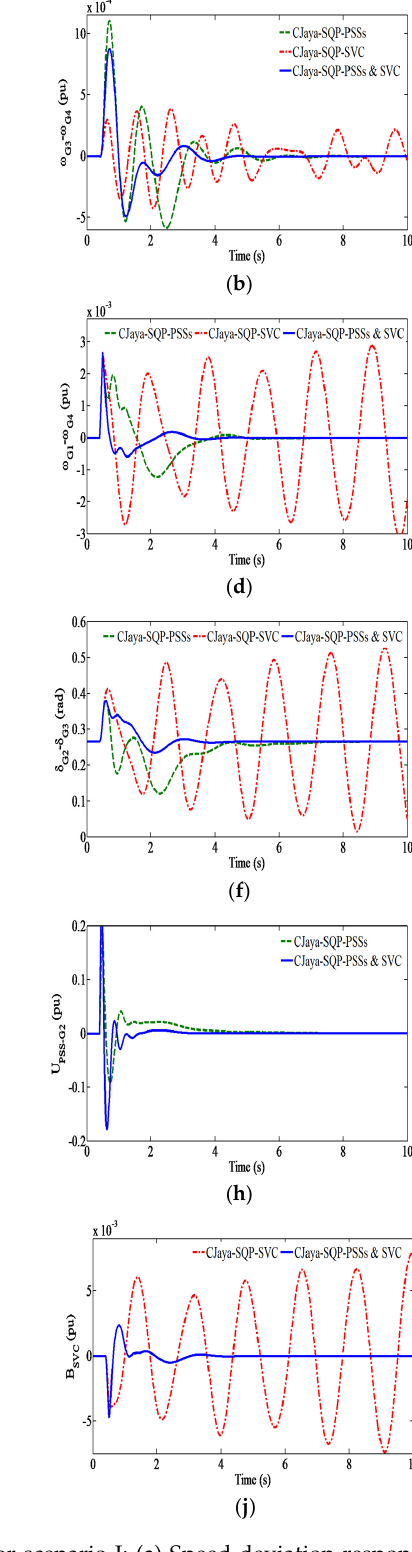
Figure 17. Power system dynamic responses for scenario I: ( a ) Speed deviation response of G1-G2; ( b ) Speed deviation response of G3-G4; ( c ) Speed deviation response of G1-G3; ( d ) Speed deviation response of G1-G4; ( e ) Rotor angle response of G1-G3; ( f ) Rotor angle response of G2-G3; ( g ) PSS output signal response at generator G1; ( h ) PSS output signal response at generator G2; ( i ) PSS output signal response at generator G4; and ( j ) SVC susceptance response. Scenario II: In this scenario, the performance of the CJaya-SQP-based tuned con- trollers is also tested under load curtailment. At 1 s t = , the load at bus 7 is disconnected for 200 ms. Figure 18 illustrates the system dynamic response for the considered load curtailment contingency. Figure 18a,b show the speed deviation response of G1-G2 and G3-G4 and depict the local mode responses of area 1 and area 2 using the three system design methodologies. Figure 18c,d show the speed deviation response of G1-G3 and G1-G4 that illustrate the inter-area mode response using the coordinated and uncoordi- nated tuning of SVC and PSSs via the CJaya-SQP method. The rotor angle responses of generators G1 and G2 with respect to G3 are shown in Figure 18e,f. It can be observed from these figures that the CJaya-SQP-SVC controller is unable to mitigate both local and inter-area mode of oscillations. Moreover, it is evident that both the CJaya-SQP-based PSSs and the CJaya-SQP-based coordinated controller have the ability to damp out the local and inter-area oscillations and stabilize the test system. Moreover, it can be seen that the proposed CJaya-SQP-PSSs&SVC controller for damping the EMOs is robust and provides the best damping performances to the local and inter-area oscillations. Figure 18g–j show the SVC susceptance response and the PSSs output signals re- sponses at generators G1, G2 and G4. It can be found from these figures that using the CJaya-SQP-based coordinated controller, the power system is controlled better than the CJaya-SQP-PSSs and thus dampens the local and inter-area oscillations quickly and effi- ciently. ( a )